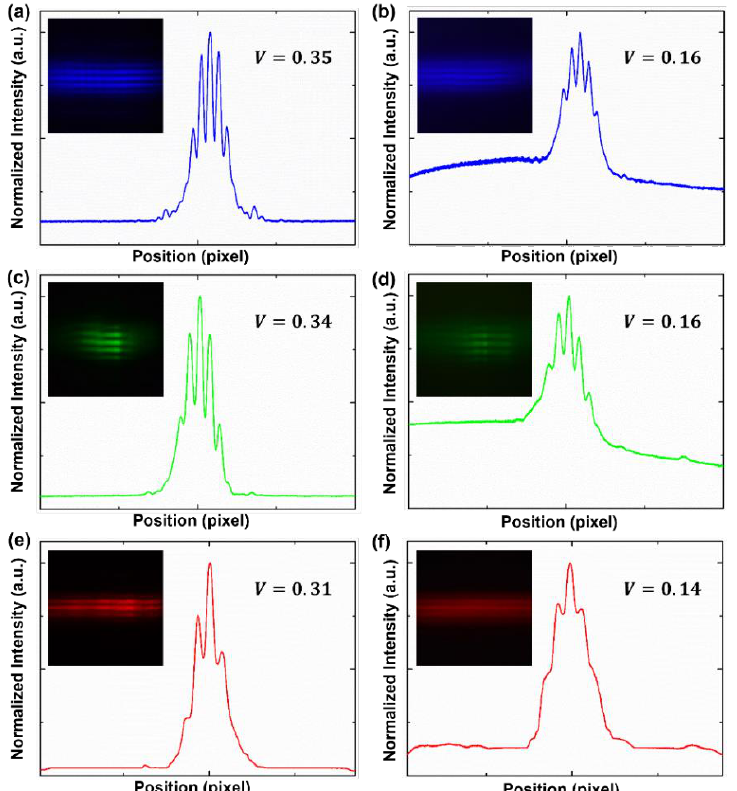
Figure 4. Regulation effect of scattering feedback on the spatial coherence of random lasing. ( a , b ) The intensity distribution and visibility of the interference fringes obtained by the double slit interference of RL B under ON state ( a ) or OFF state ( b ). ( c , d ) The intensity distribution and visibility of the interference fringes for the RL G under ON state ( c ) or OFF state ( d ). ( e , f ) The intensity distribution and visibility of the interference fringes for the RL R under ON state ( e ) or OFF state ( f ). Illustrations are the optical photos of the interference fringes, respectively.